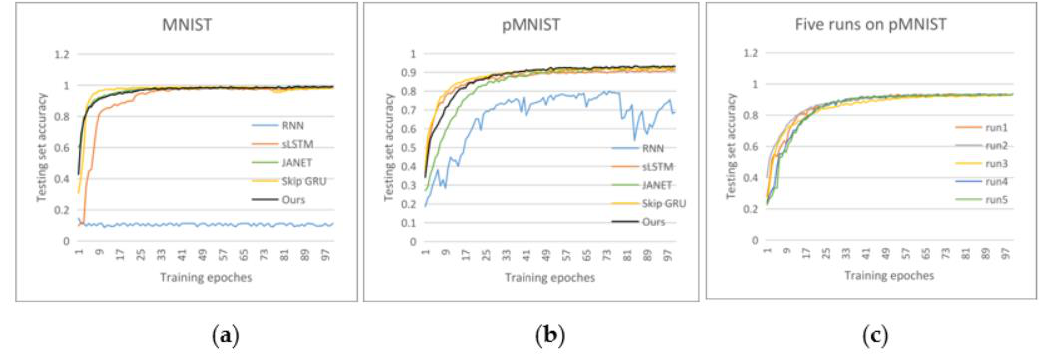
Figure 2. The change in test accuracy with training epochs. ( a ) accuracy on the MNIST, ( b ) accuracy on the pMNIST, ( c ) accuracy over five runs on the pMNIST.